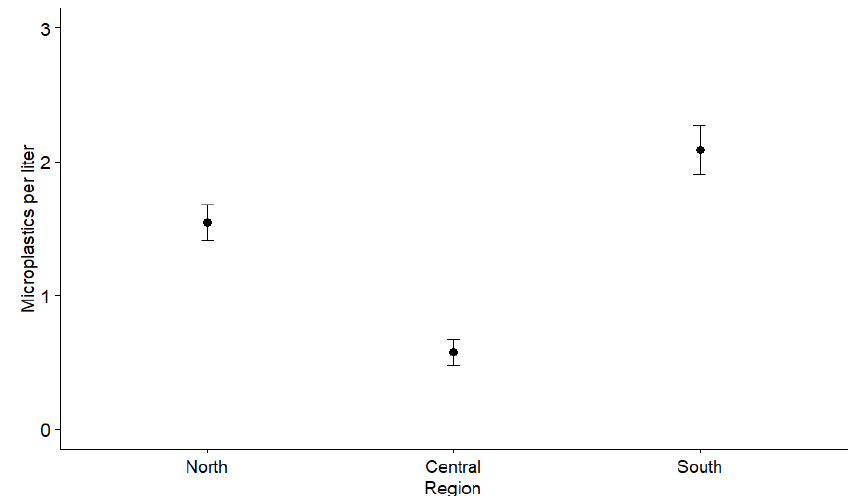
Figure 2. Microplastic abundance per liter of water from the north, central, and south Indian River Lagoon. Values are mean abundance (point) and 95% confidence interval of the mean. (GLM, p < 0.05, North = 716, Central = 598, South = 776).